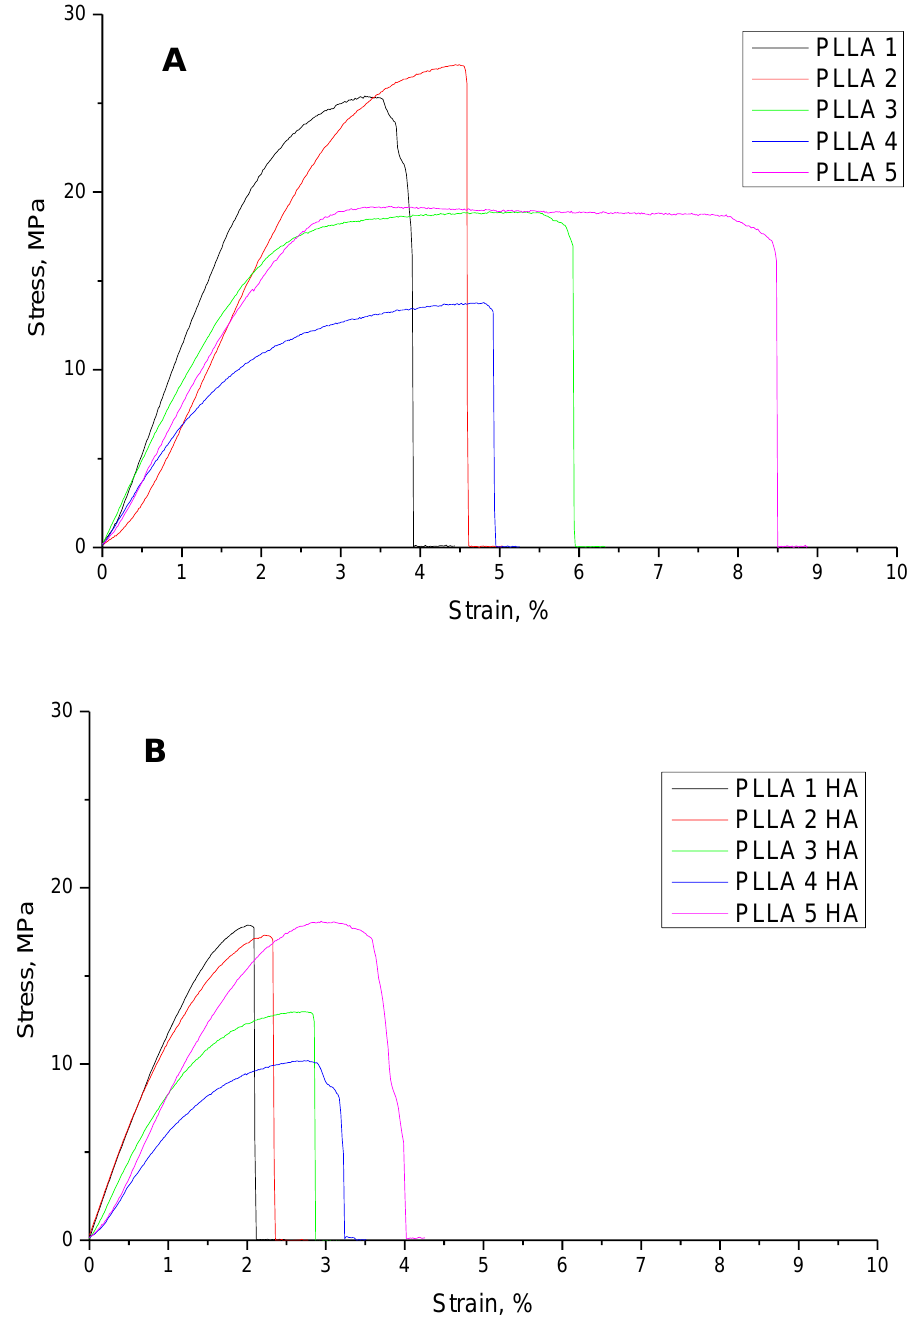
Figure 5. Tensile test curves for PLLA films without ( A ) and with ( B ) addition of 20 wt% of hydrox-